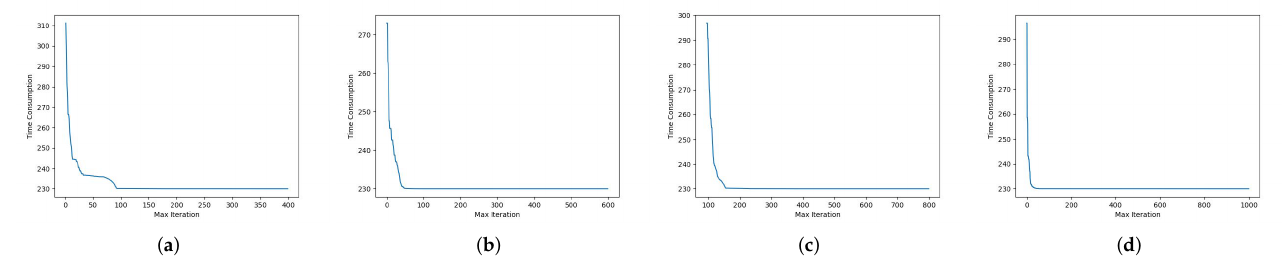
Figure 9. PSO solution process based on different parameter settings. ( a ) PSO process based on parameter P1, ( b ) PSO process based on parameter P2, ( c ) PSO process based on parameter P3, ( d ) PSO process based on parameter P4.